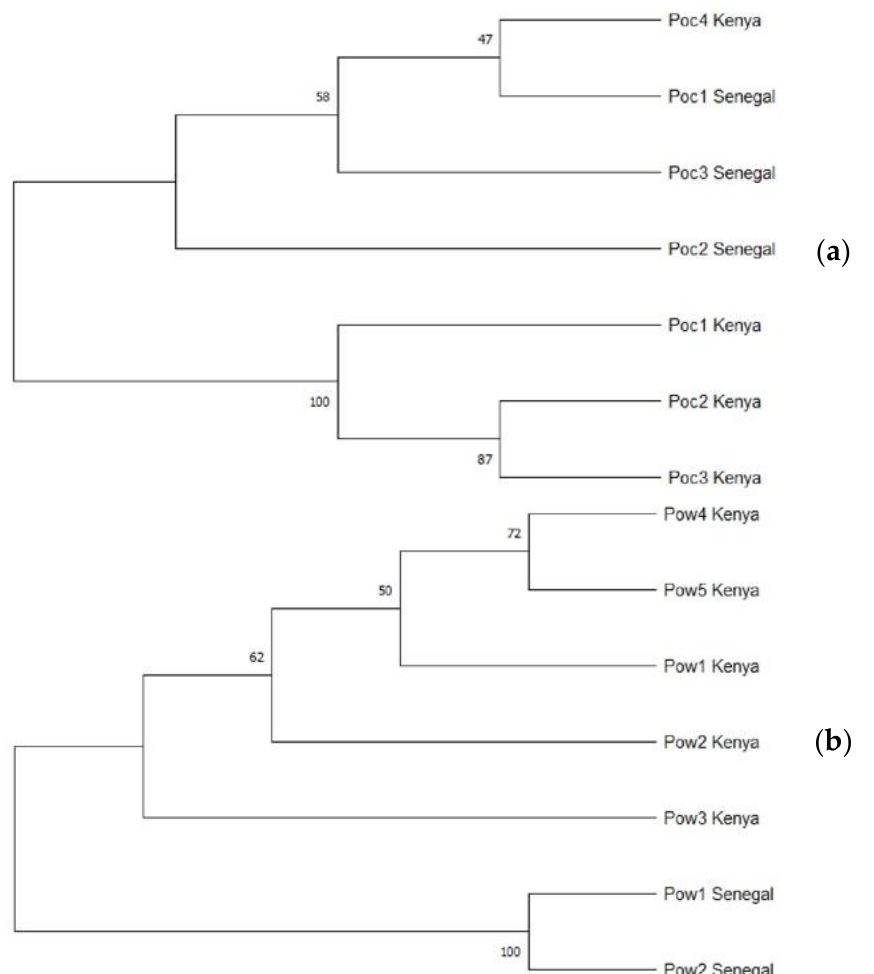
Figure 3. Phylogenetic profile of Plasmodium ovale subspecies from different parts of Africa; profiling with tryptophan-rich antigen gene of P. ovale curtisi from Kenya and Senegal ( a ); profiling with tryptophan-rich antigen gene of P. ovale wallikeri from Kenya and Senegal ( b ).